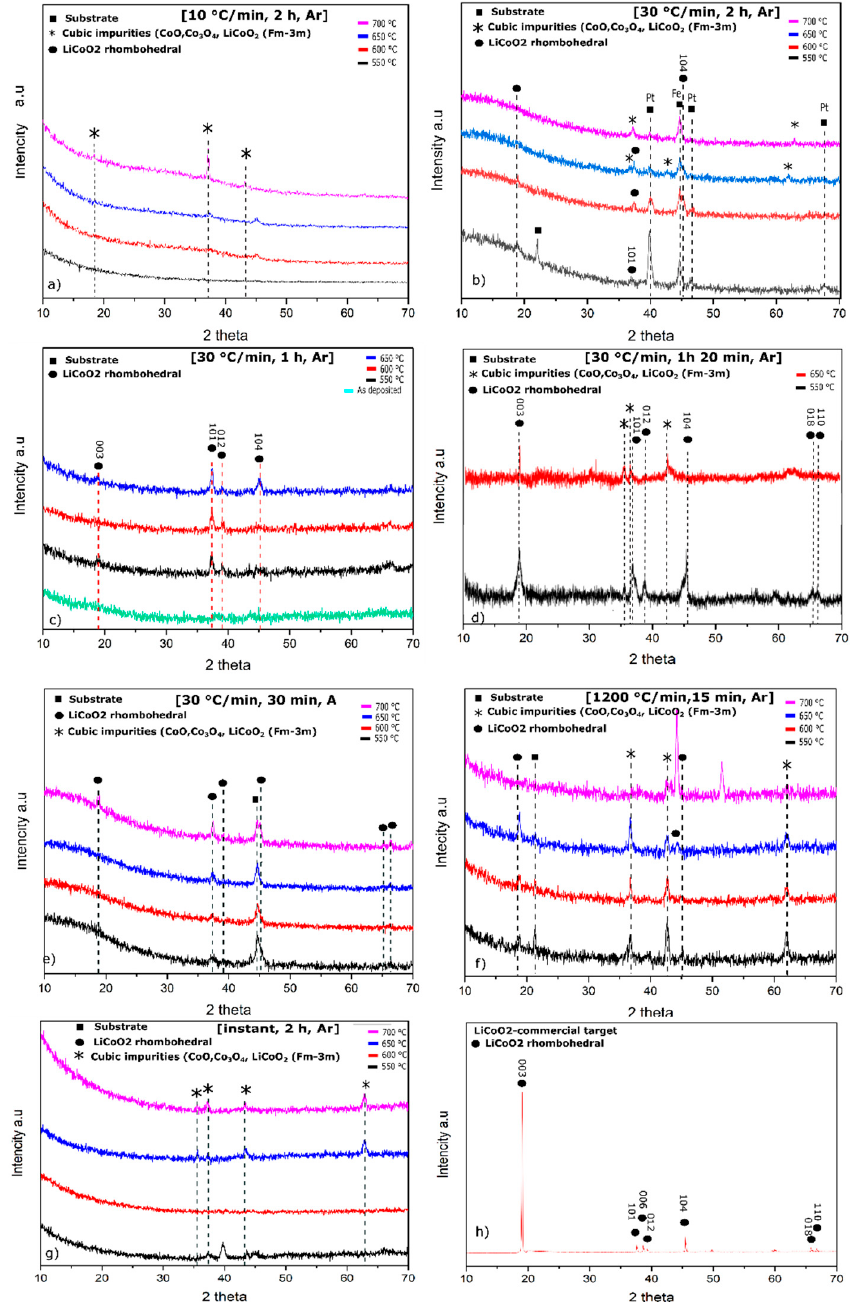
Figure 2. XRD pattern of annealed LiCoO 2 thin films in Ar atmosphere with changing annealing times, temperatures, and ramp rates: ( a ) 10 °C min − 1 , annealed 2 h; ( b ) 30 °C min − 1 , 2 h; ( c ) 30 °C min − 1 , 1 h; ( d ) 30 °C min − 1 , 1 h 20 min; ( e ) 30 °C min − 1 , 30 min; ( f ) 1200 °C min − 1 , 15 min; ( g ) instant, 2 h; ( h ) commercial target .